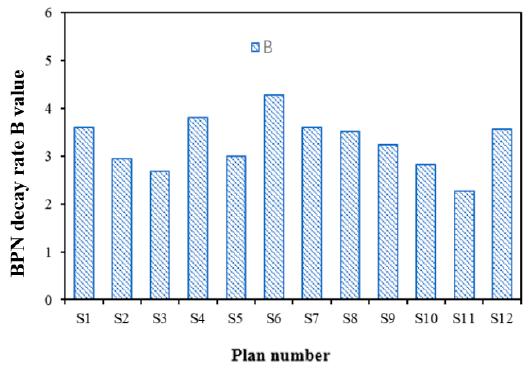
Figure 12. BPN attenuation rate comparison.